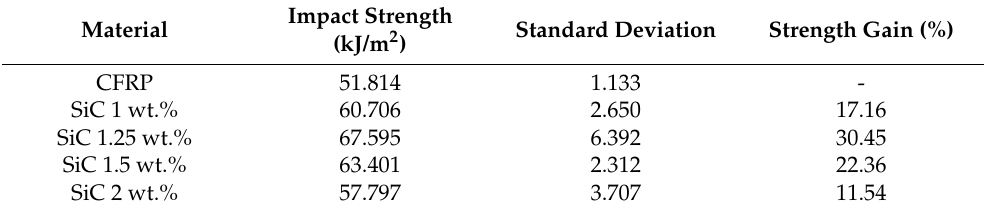
Table 11. Impact strength of neat and hybrid SiC nanocomposites.